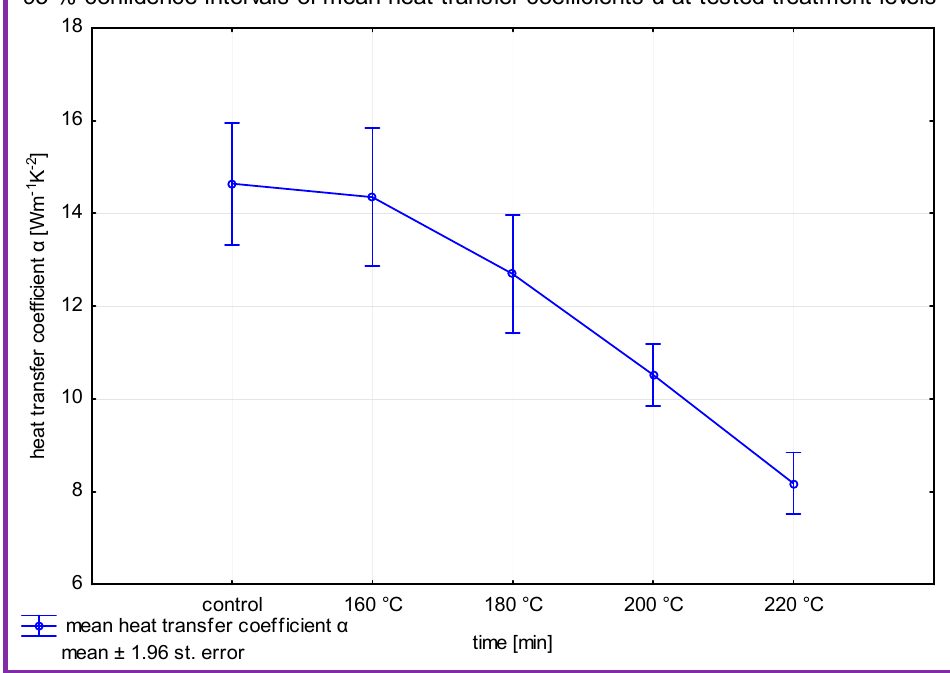
Figure 7. Box plot of 95% confidence intervals of the mean heat transfer coefficient α at tested treatment